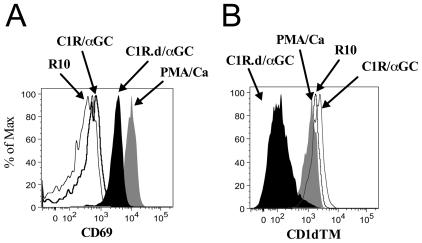
Activation and TCR downregulation in sooty mangabey NKT clones.Representative histogram plots on one NKT cell clone showing (A) surface expression of CD69 and (B) TCR detection by CD1d TM following 16 hours in vitro stimulation with the NKT-specific ligand α-GalCer presented on C1R cell lines expressing CD1d (C1R.d/α-GC), C1R cell lines pulsed with α-GalCer (C1R/α-GC), PMA/Ca or medium alone (R10).